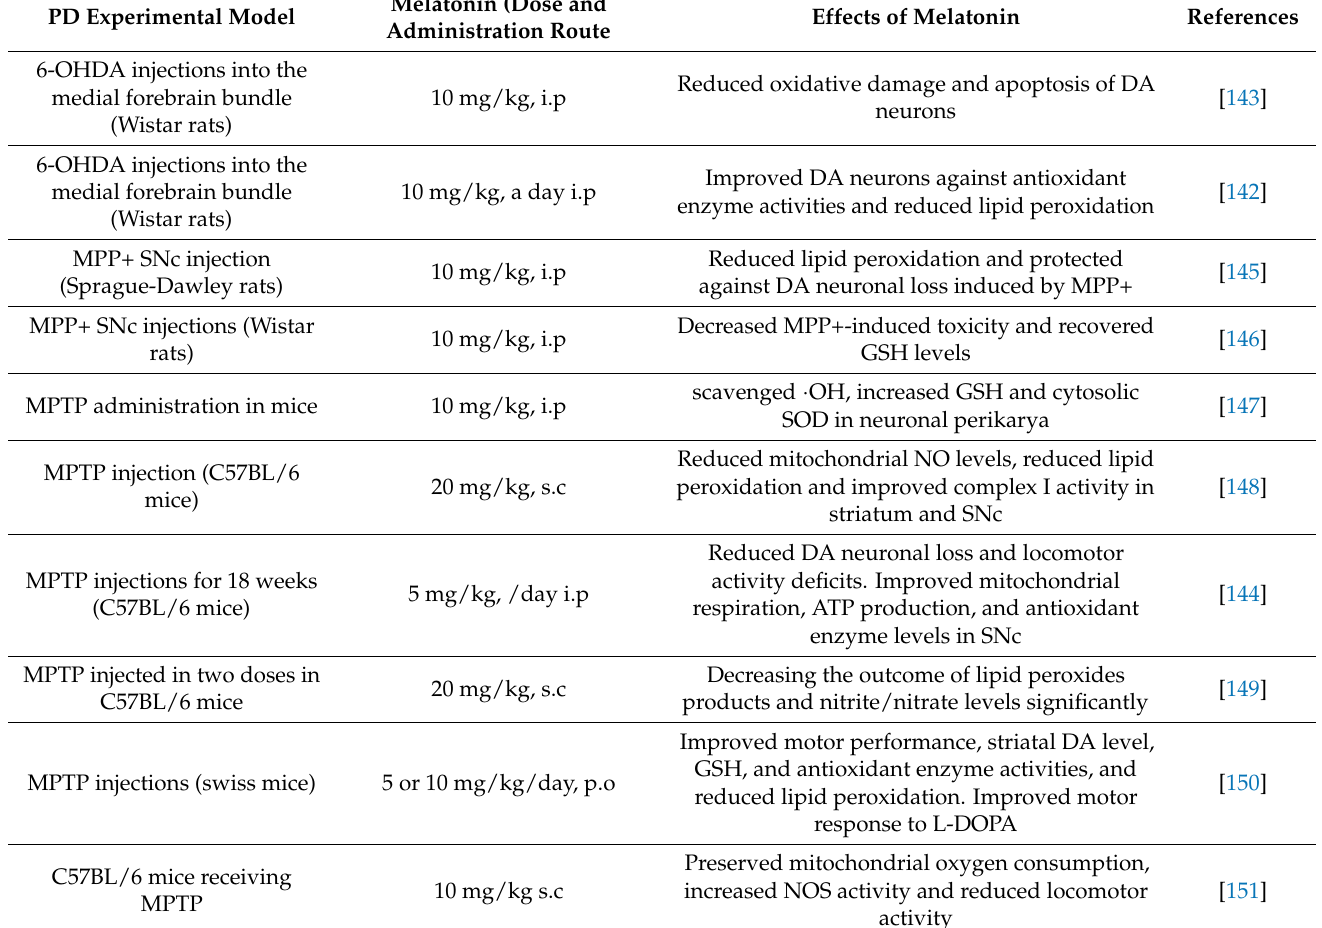
Table 4. Effects of melatonin on oxidative stress in animal PD